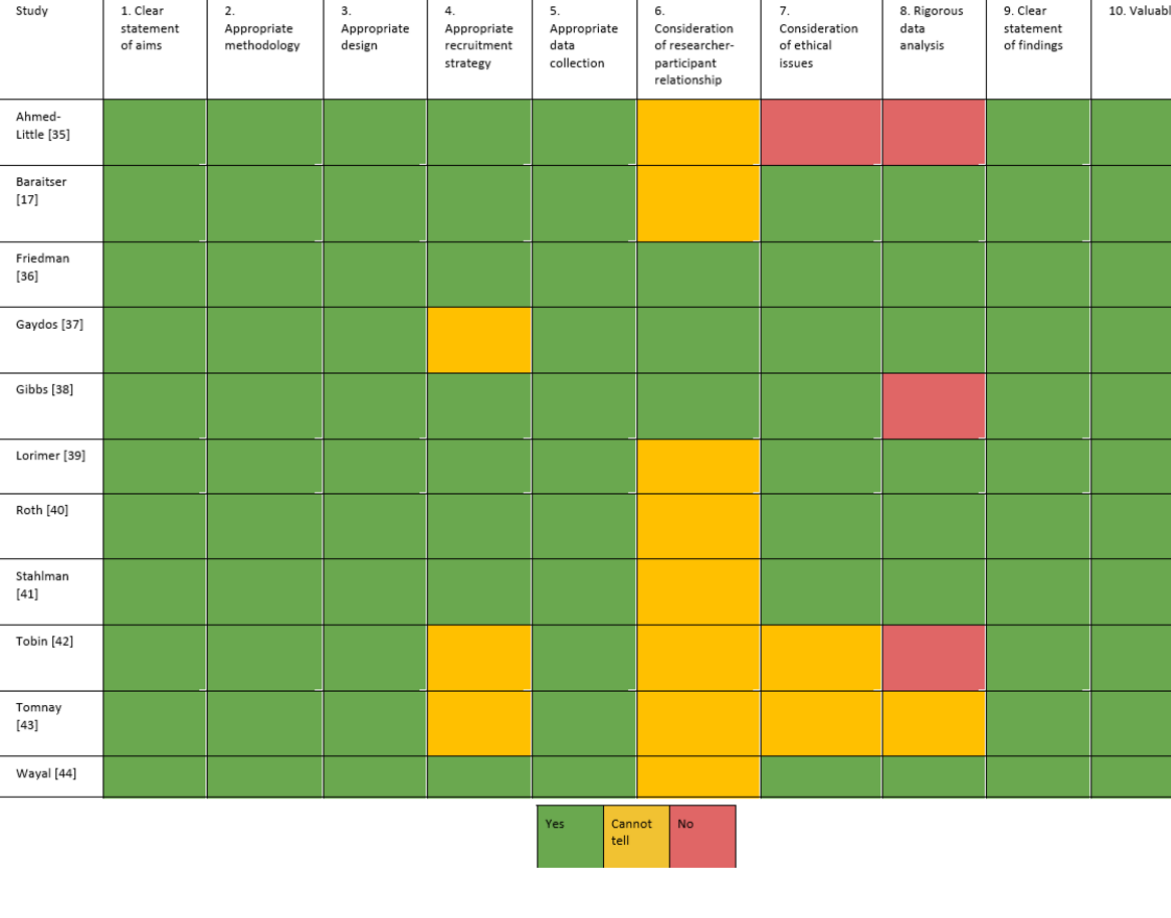
Table 2. Summary of